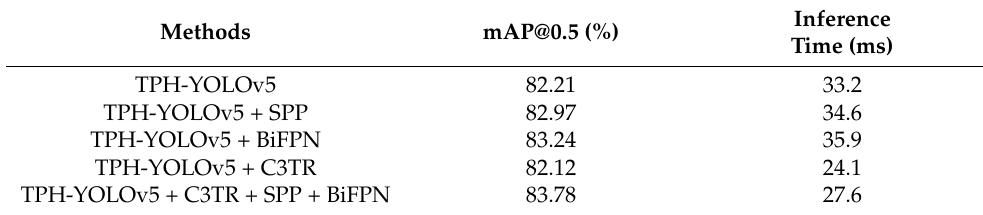
Table 3. Ablation study on our dataset. TPH-YOLOv5+C3TR denotes that TPH-YOLOv5 uses transformer encoder blocks after the backbone and before the last detection head only, removing the transformer encoder blocks in front of the first three detection